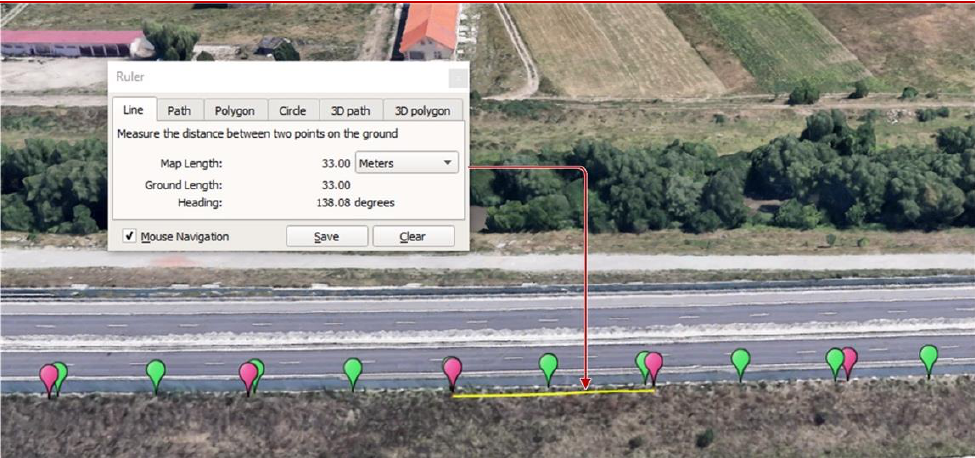
Figure 16. Evaluating the distance between two consecutive measurement points (Google Earth) for space resolution assessment in the case of the moving sensor.